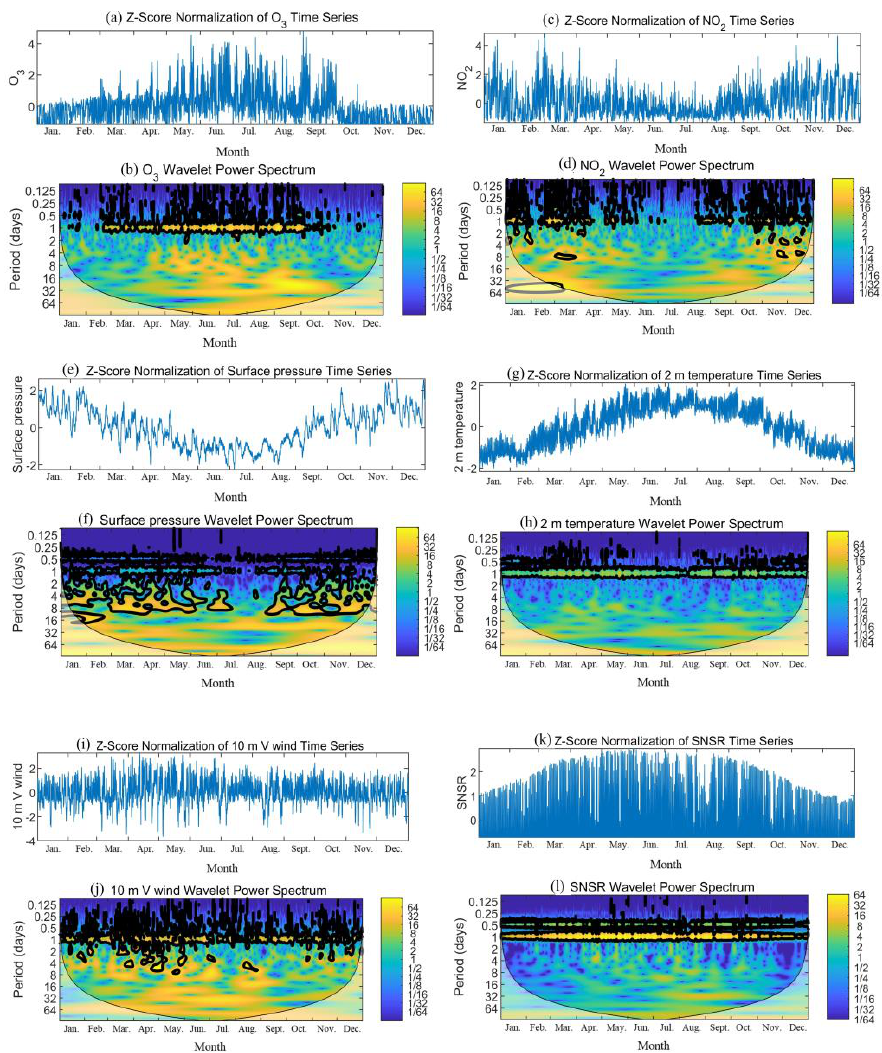
Figure 2. Z-score normalization time series and wavelet power spectrum for ( a , b ) O 3 ; ( c , d ) NO 2 ; ( e , f ) surface pressure; ( g , h ) 2 m temperature; ( i , j ) 10 m V wind; and ( k , l ) net surface net solar radiation.